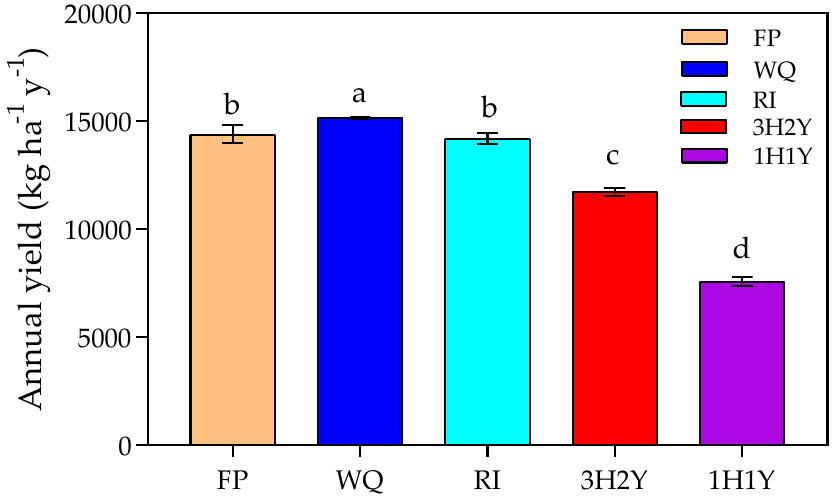
Figure 4. Average annual crop yields under different cropping systems. Error bars represent the standard error. Different lowercase letters indicate significant differences among yields under different treatments ( p < 0.05).